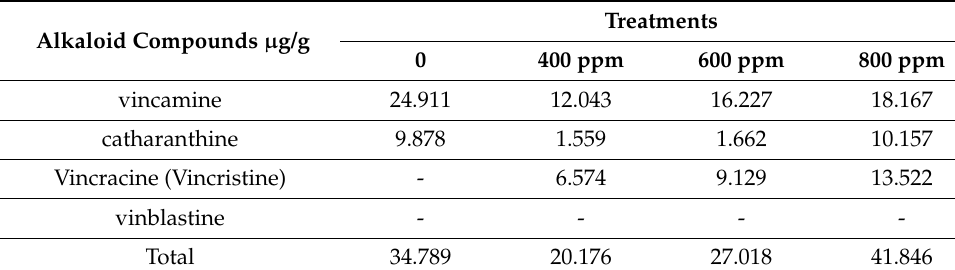
Table 5. Effect of κ -carrageenan treatments on alkaloids contents of Catharanthus roseus leaves identified by HPLC.